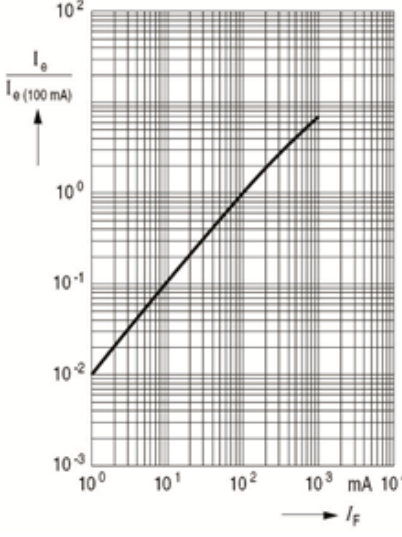
Figure 5. Relationship between IRED radiant intensity and the bias current.